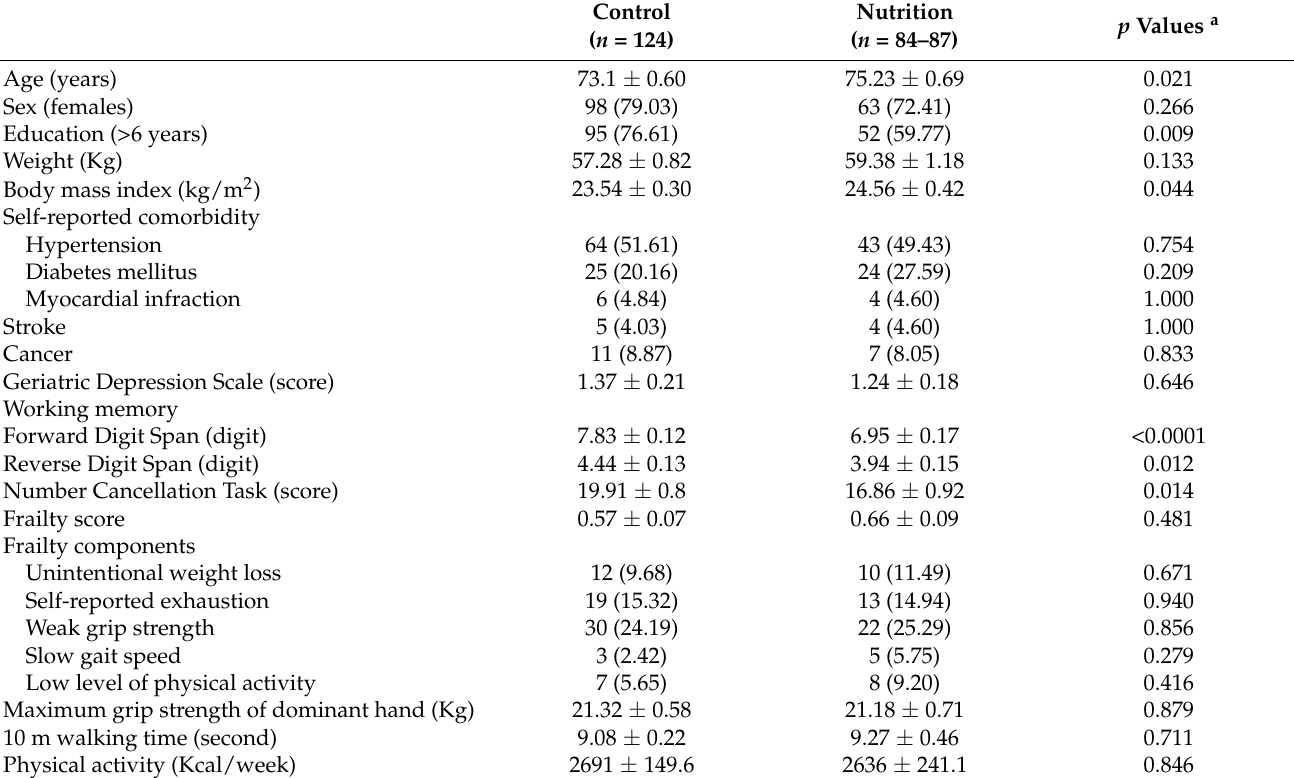
Table 1. Baseline characteristics of subjects 1